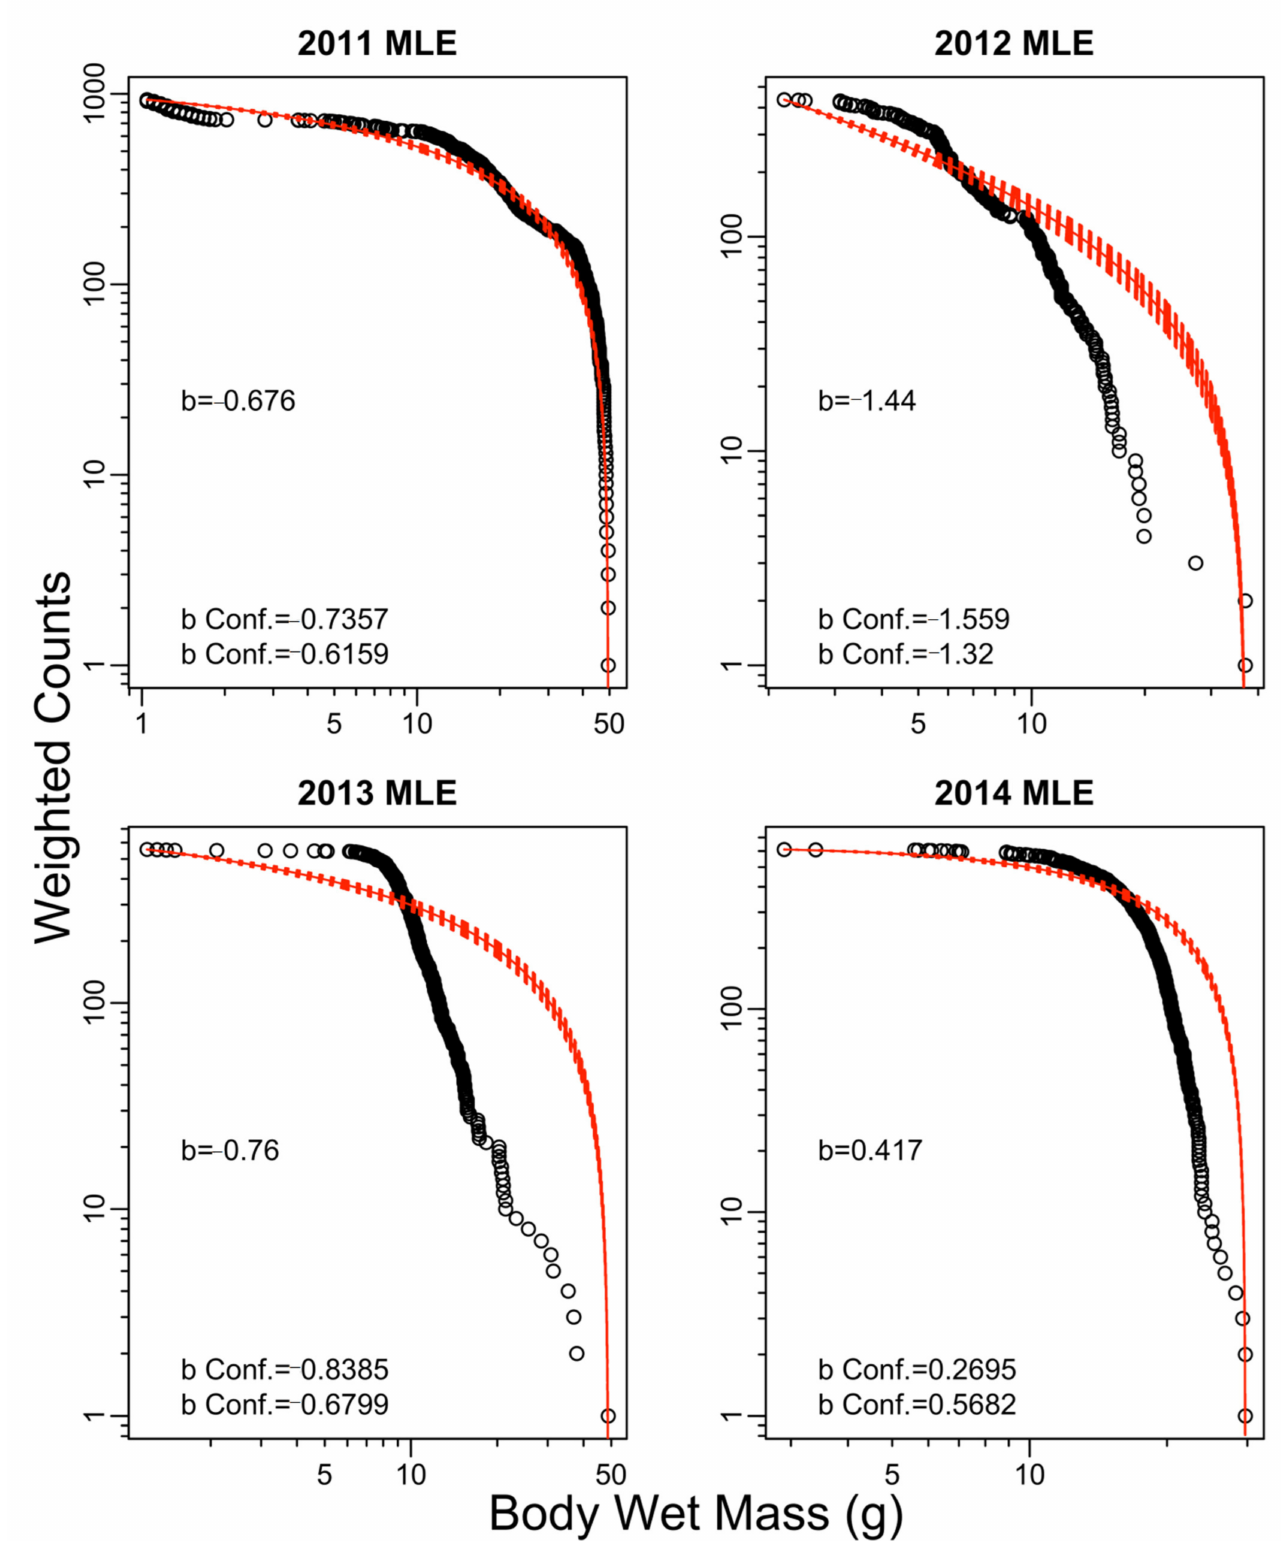
Figure A2. Fish SS with counts and body wet mass (g) fitted using the maximum likelihood estimate of exponent b with the 95% confidence interval of b based on trawling surveys for